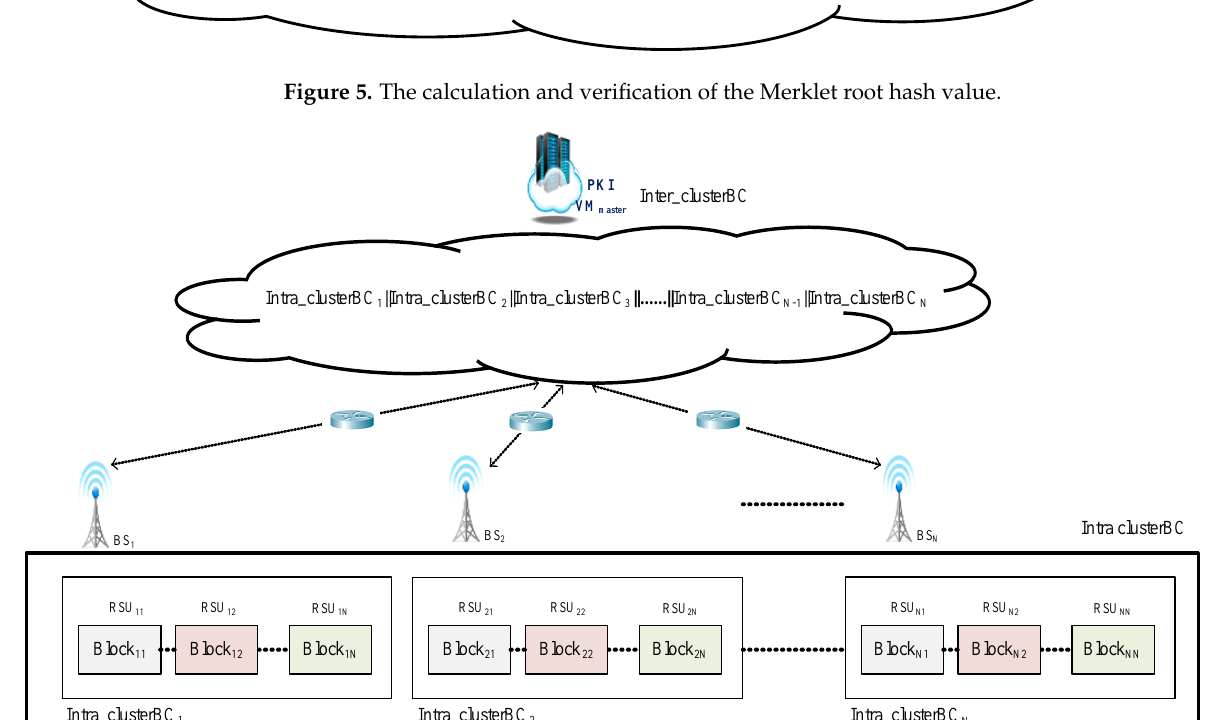
Figure 6. The multi-level blockchain framework for Internet of vehicles.